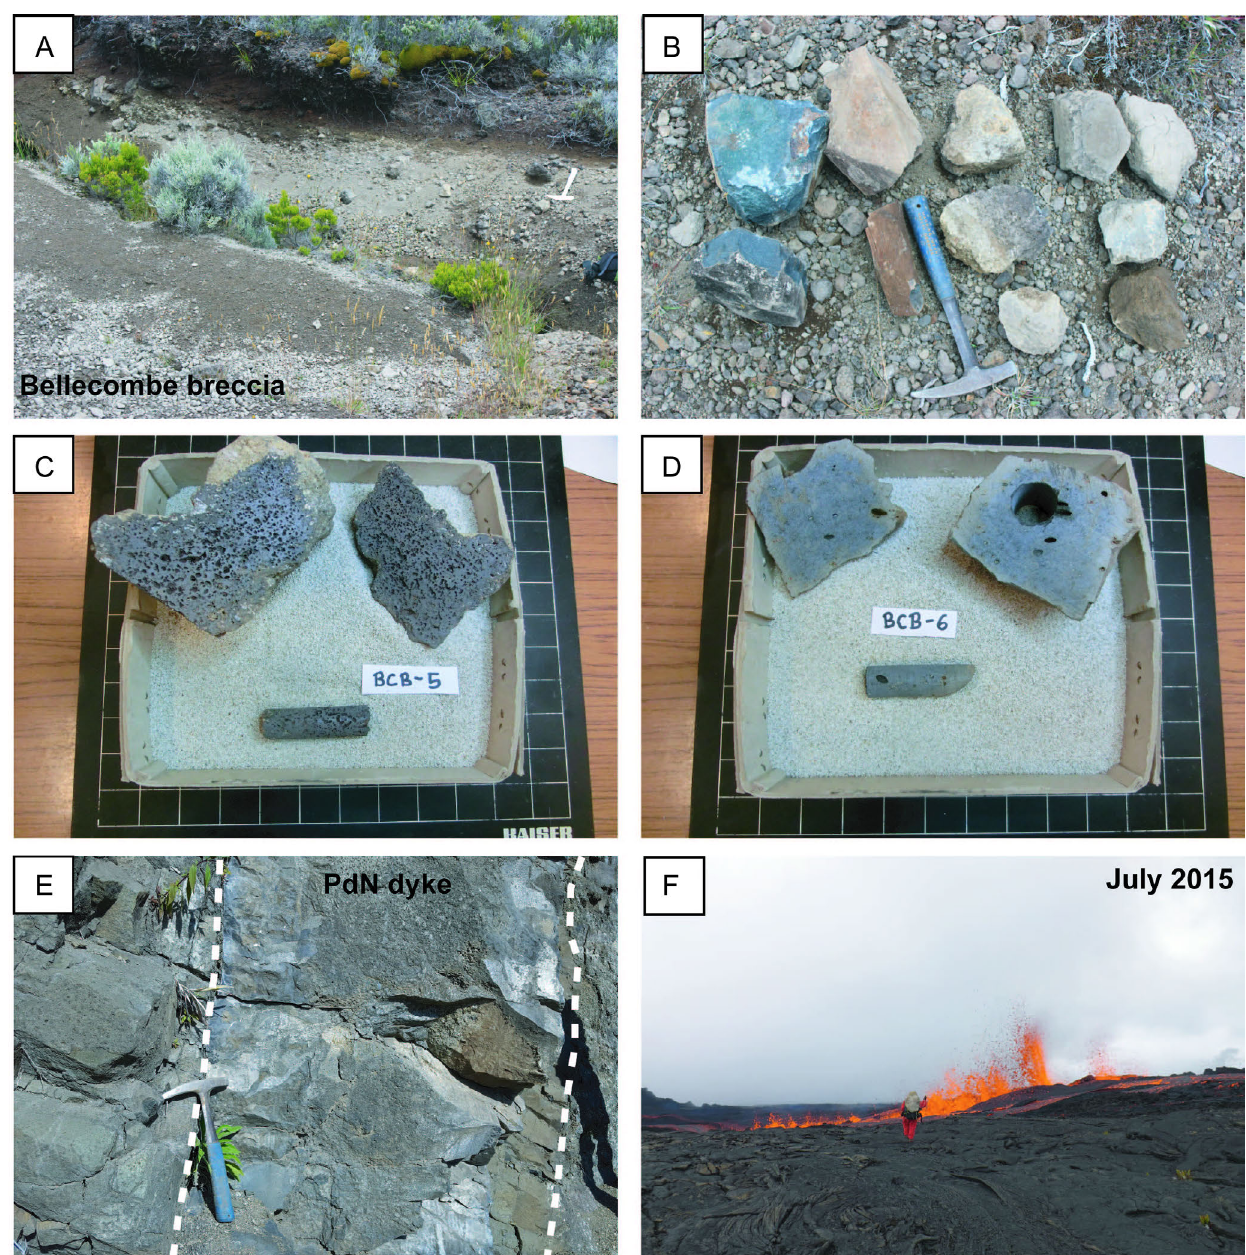
Figure 2: Examples of different samples and sample sources [A]: Bellecombe breccia at the Piton de Bert site; [B] lithic blocks extracted from the Bellecombe breccia at the Piton de Bert sample; [C] vesicular lava sample from the Bellecombe breccia (Piton de Bert site) [D] dense fine-grained block from the Bellecombe breccia (Piton de Bert site) [E] Subvertical dyke of Piton des Neiges at Cilaos; note well-developed chilled outer margins; [F] July 2015 lava flow. Hammer for scale in [A], [B] and [E]. Cylinders have a diameter of 2.0 cm in [C] and [D]. Person for scale in